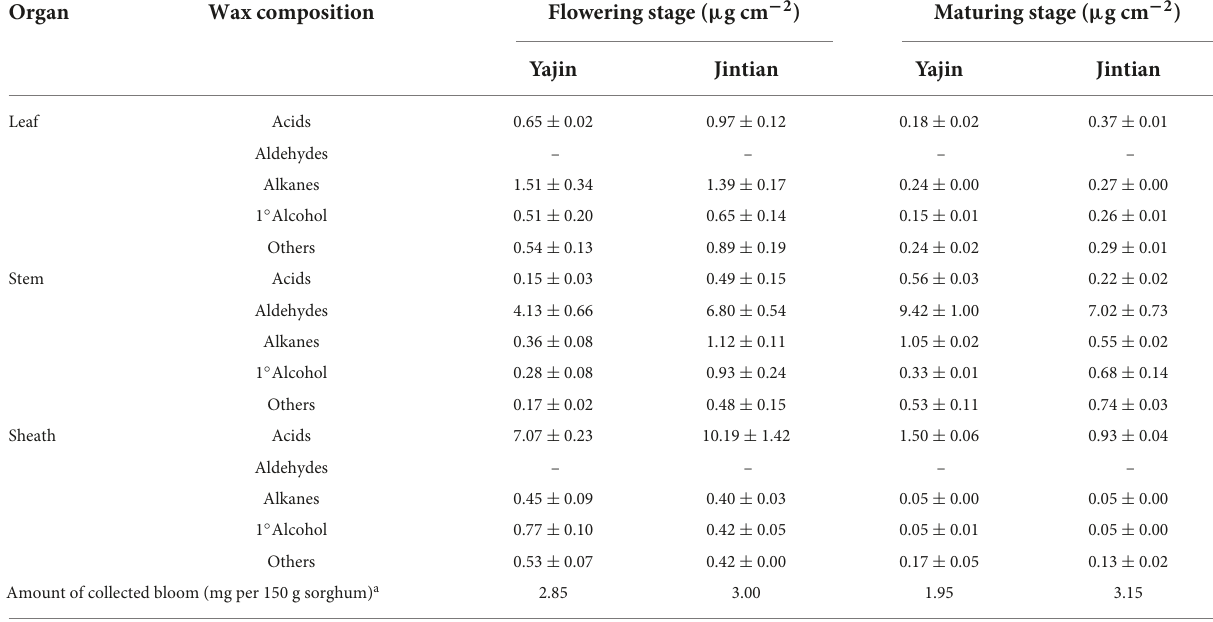
TABLE 1 Cuticular wax profiles on organs of sweet sorghum and the amount of bloom collected from sheath. Organ Wax composition